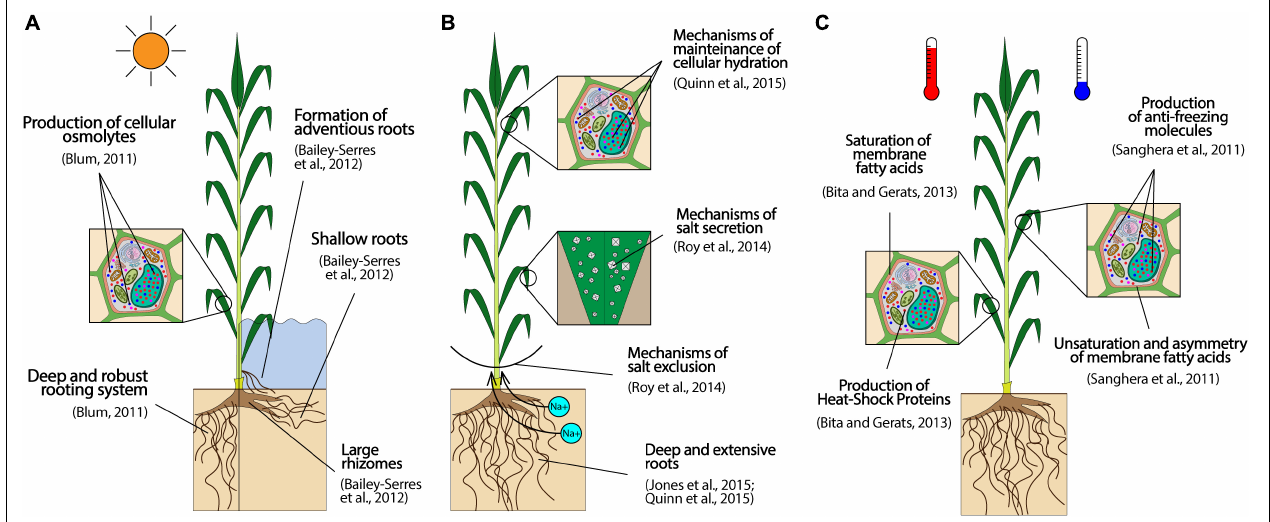
FIGURE 2 | Preeminent target traits to equip perennial lignocellulosic biomass crops with effective resistance to common abiotic stresses of MALs: drought ( A , left), flooding ( A , right), salinity (B) , and extremely warm ( C , left) or cold ( C , right) temperatures. The traits reported represent an ideotype to guide breeding activities, and the effective magnitudes of improvement attainable with respect to each trait can vary extensively depending on the species object of a breeding